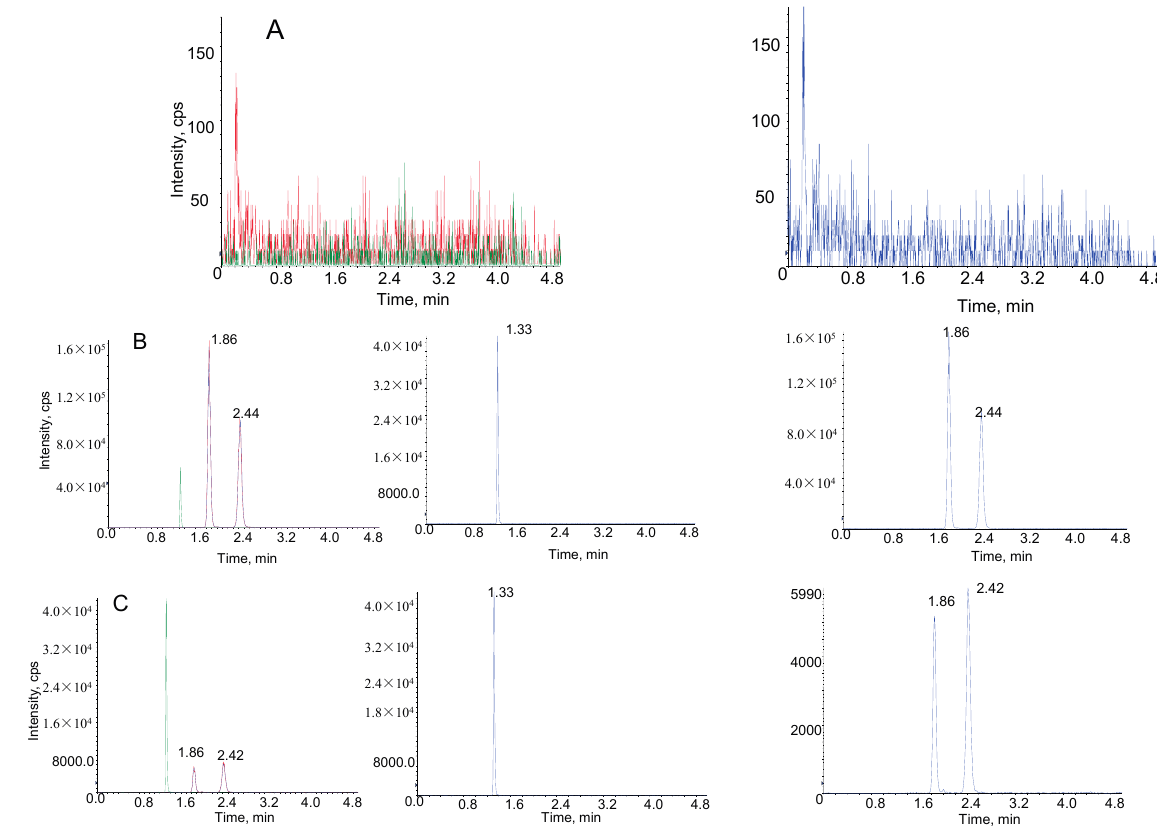
Figure 4. Representative multiple reaction monitoring chromatograms of SSa, SSd and IS in rat plasma. ( A ) Blank plasma sample; ( B ) plasma sample obtained 60 min after intravenous administration of SSa-SSd-lip at dosages of SSa and SSd were 1 mg/kg; ( C ) blank plasma sample spiked with 5.00 ng/mL of SSa/SSd and 1000 ng/mL of IS. Precision and